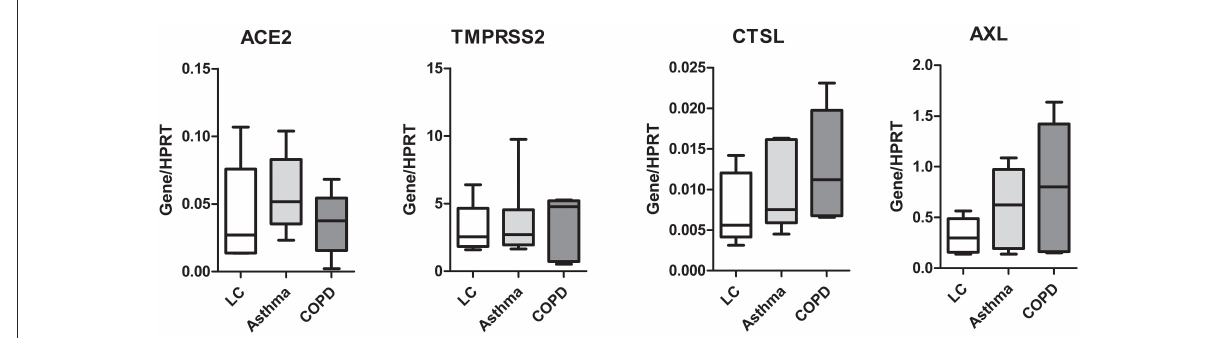
FIGURE3 Expression of SARS-CoV-2 entry genes is not associated with asthma or COPD. SAEC isolated from patients with lung cancer (LC; 4 patients, 5 cultures), LC with asthma (4 patients, 6 cultures), and LC with COPD (3 patients, 5 cultures) were ALI cultured. Gene expression was analyzed by LightCycler PCR and normalized to HRPT expression. Data are presented as Box and Whiskers (min to max) and statistical significance was tested by one-way ANOVA followed by Tukey’s Multiple Comparison Test, or Kruskal-Wallis test followed by Dunn’s Multiple Comparison